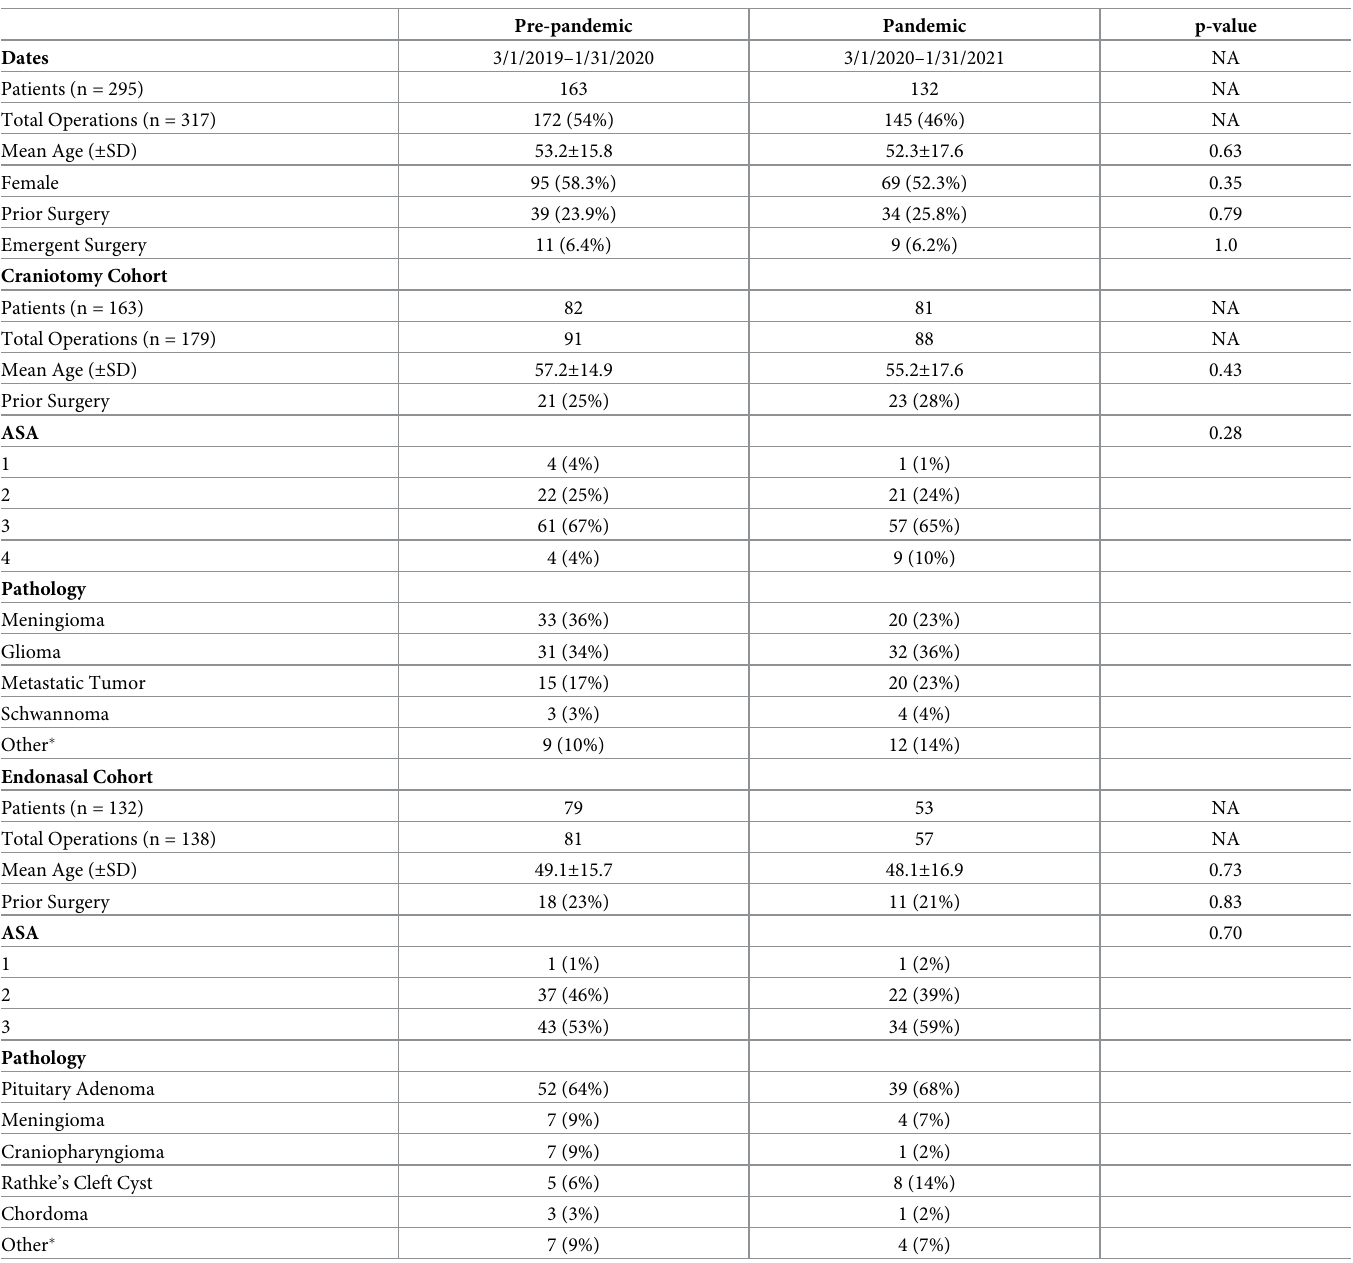
Table 2. Demographics by epoch and surgical